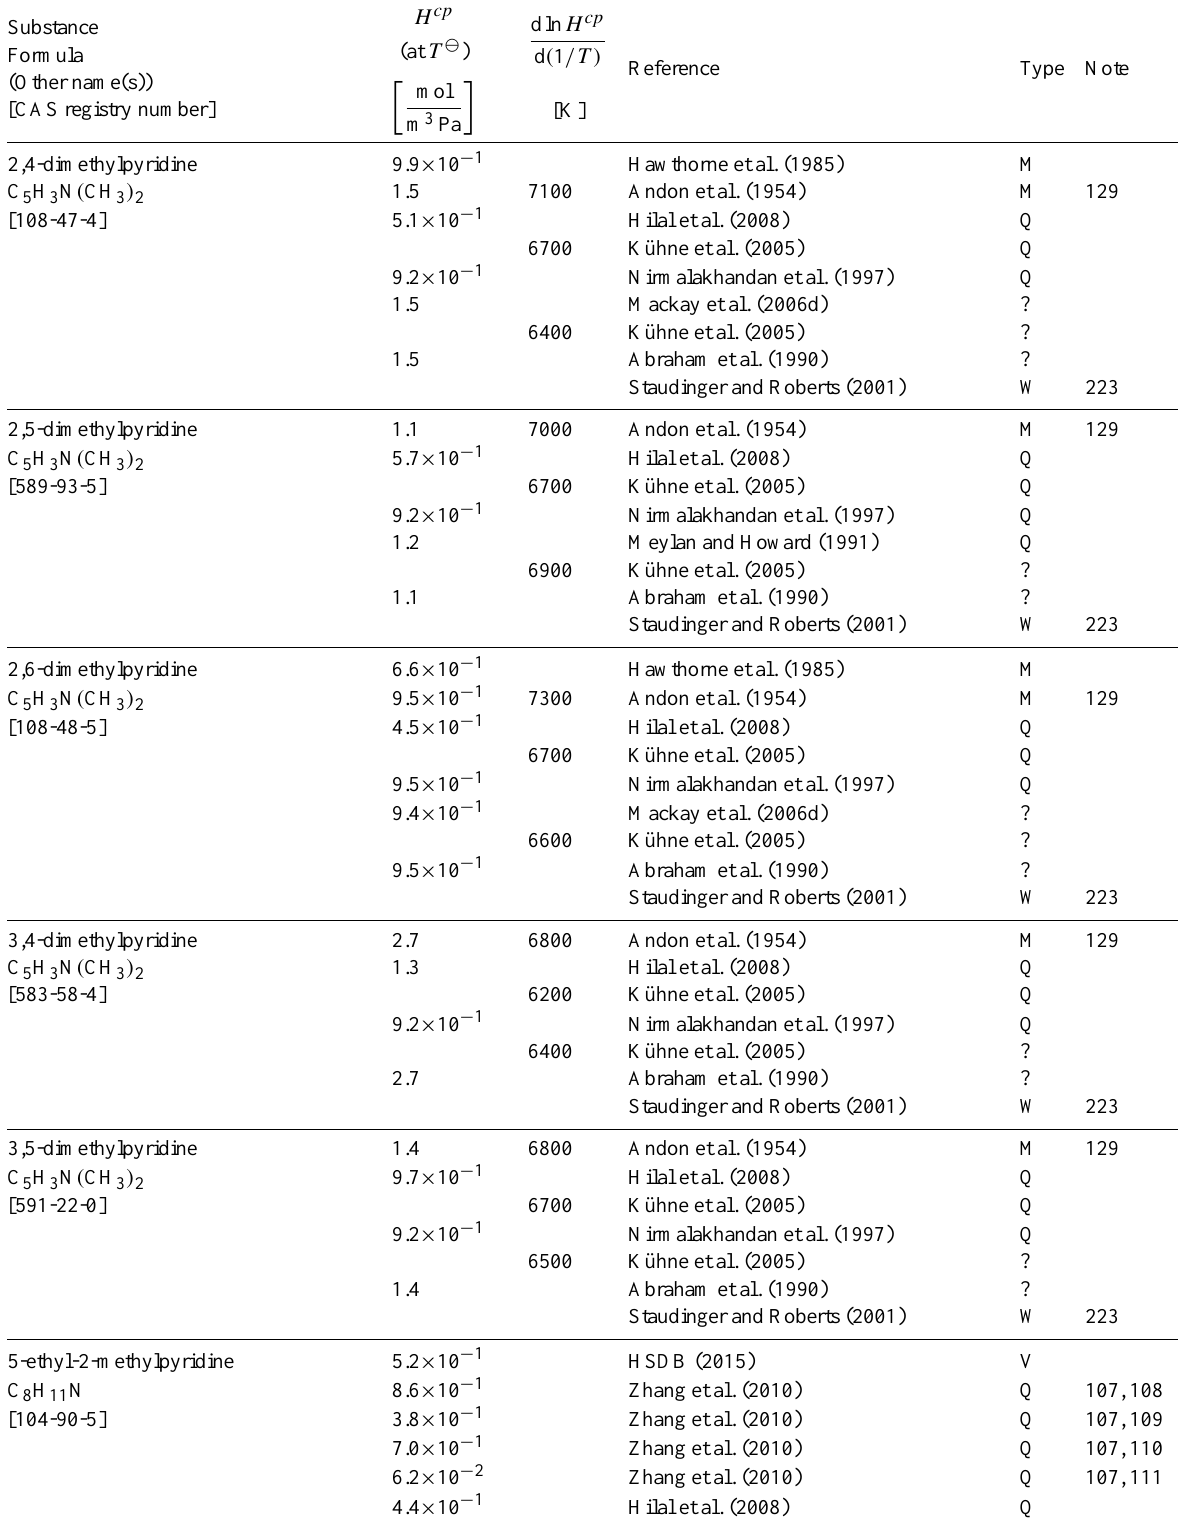
Table 6: Henry’s law constants for water as solvent